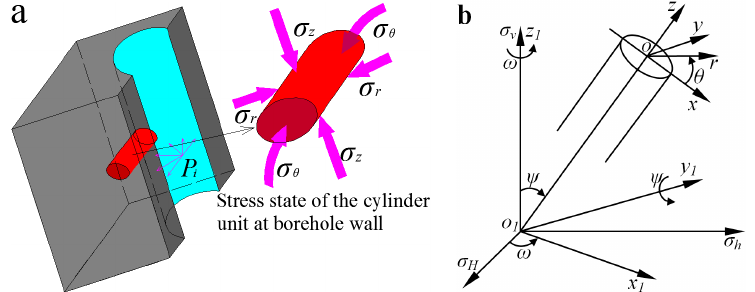
Figure 2. Stress state of the wellbore unit: ( a ) the formation unit; ( b ) the conversion of coordinates for an inclined wellbore.